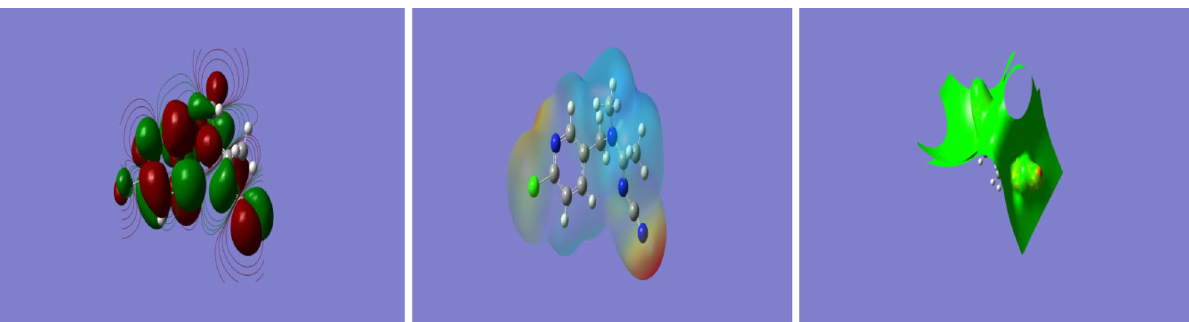
Figure 16. Acetamiprid electrostatic potential